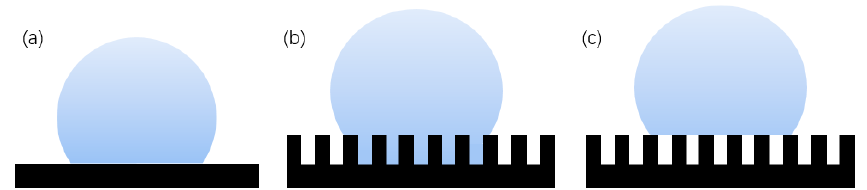
Figure 4. Theoretical model of hydrophobicity: ( a ) Young’s model, ( b ) Wenzel structure model, and ( c ) Cassie–Baxter structure model.